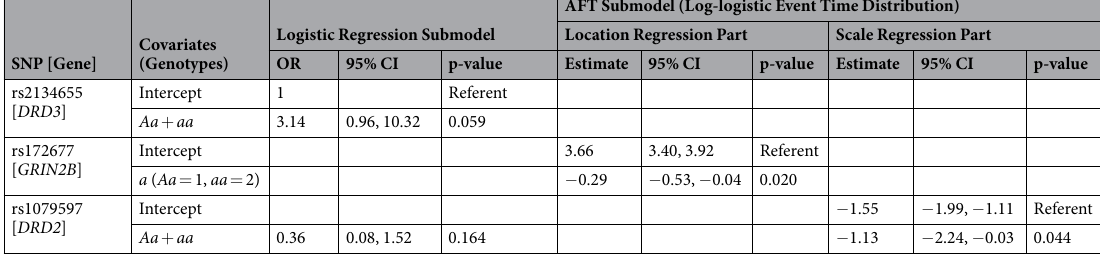
Table 2. Multiple-SNPs analysis by using the logistic-AFT mixture regression model with chi-squared statistic 15.48 (p = 0.004) of the likelihood ratio test in the mixture model. Abbreviations: OR, odds ratio; CI, confidence interval.